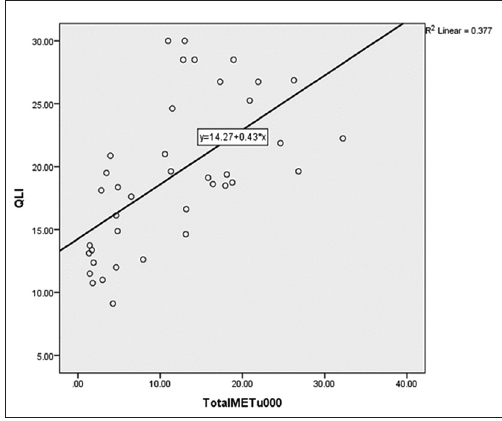
FIGURE 1. The scatter plot and regression line show that daily activities have a positive effect on the quality of life of working indi‑ viduals with hearing and speech disabilities (B = 0.433, p < 0.05).